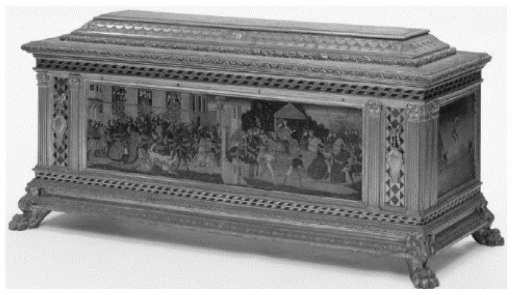
Figure 3. Apollonio di Giovanni, and Marco del Buono. Teseida: Duel of Arcita and Palemon and Triumphal Procession . c.1465. Boston: Museum of Fine Arts, Bequest of Mrs. Martin Brimmer, 06.2441.